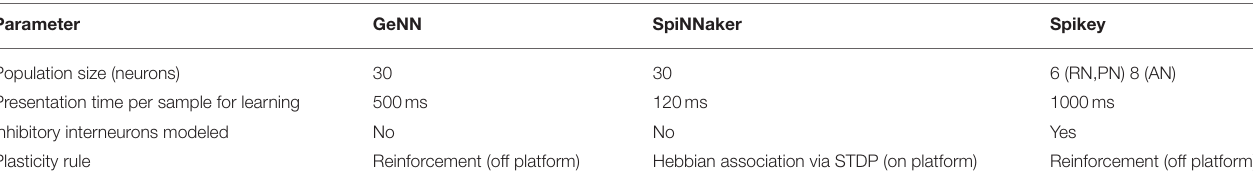
TABLE 1 | Major parameterizations of models used for each platform.